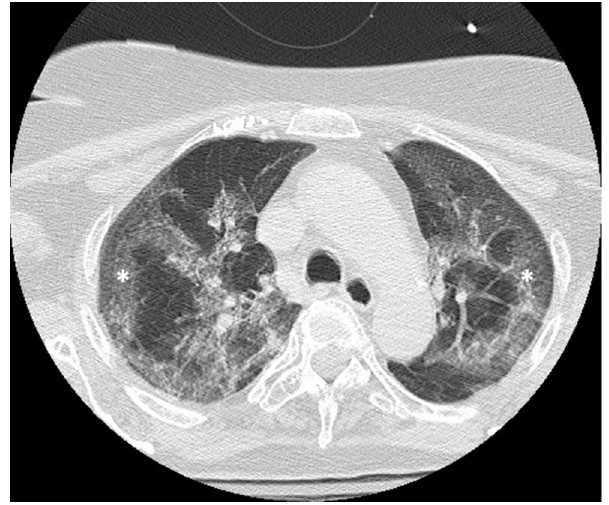
Figure 3. Axial CT image shows ground-glass opacity superimposed by interlobular and intralobular septal thickening (asterisk).